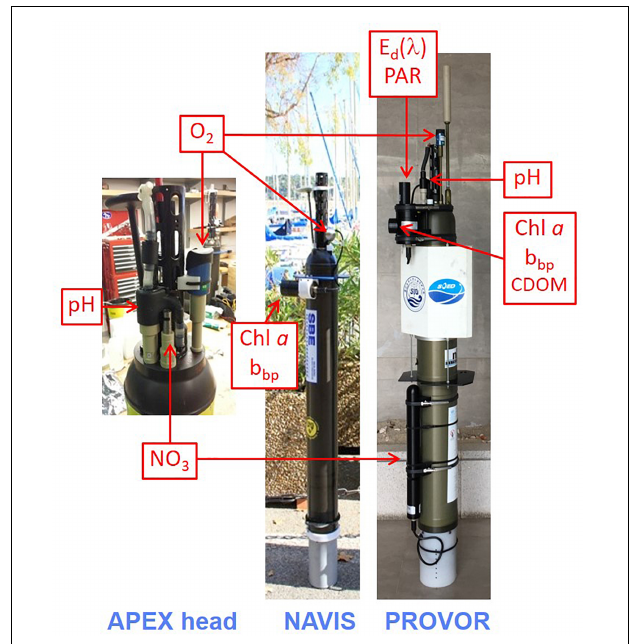
FIGURE 8 | Examples for biogeochemical sensor attachments and implementations on different float platforms. Note that BGC sensors can be vertically displaced relative to the CTD pressure sensor. This displacement should be recorded in the float’s meta